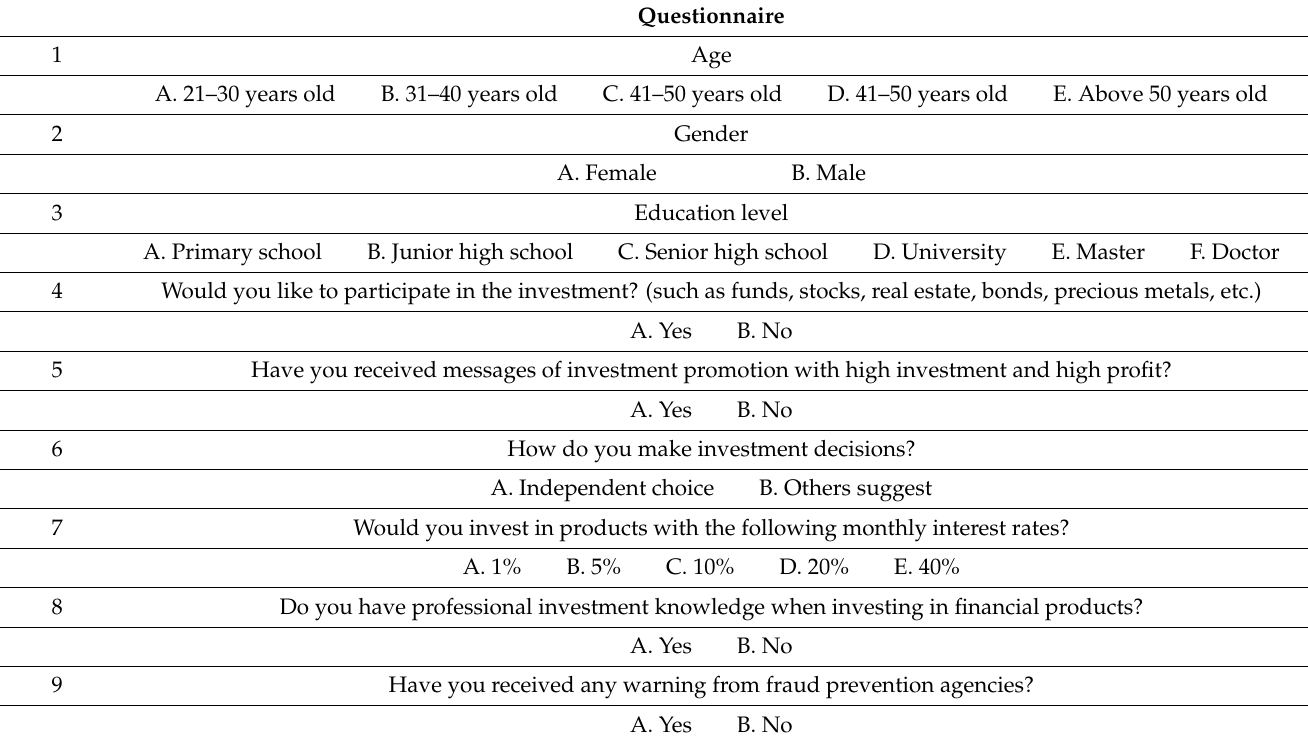
Table A1. The questionnaire survey project description table.